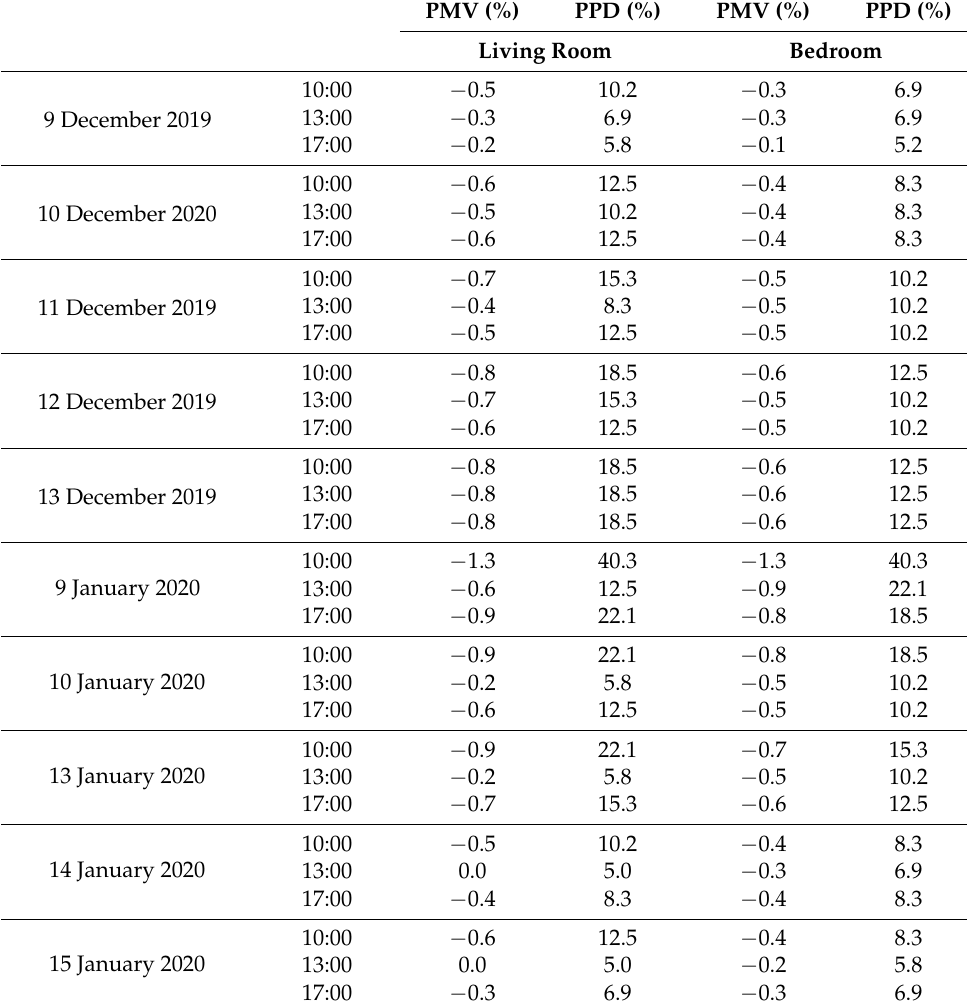
Table 3. PMV and PPD calculated